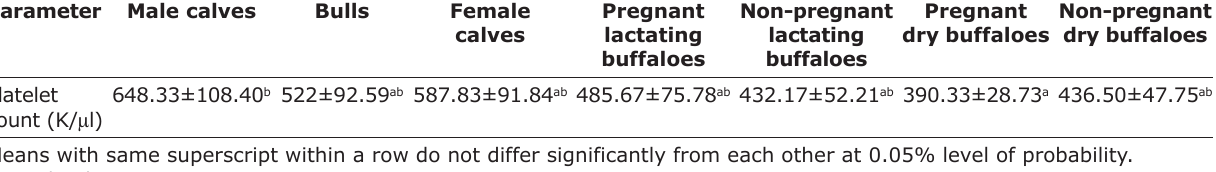
Table-3: PLT count of different experimental groups of Banni buffaloes. Parameter Male calves